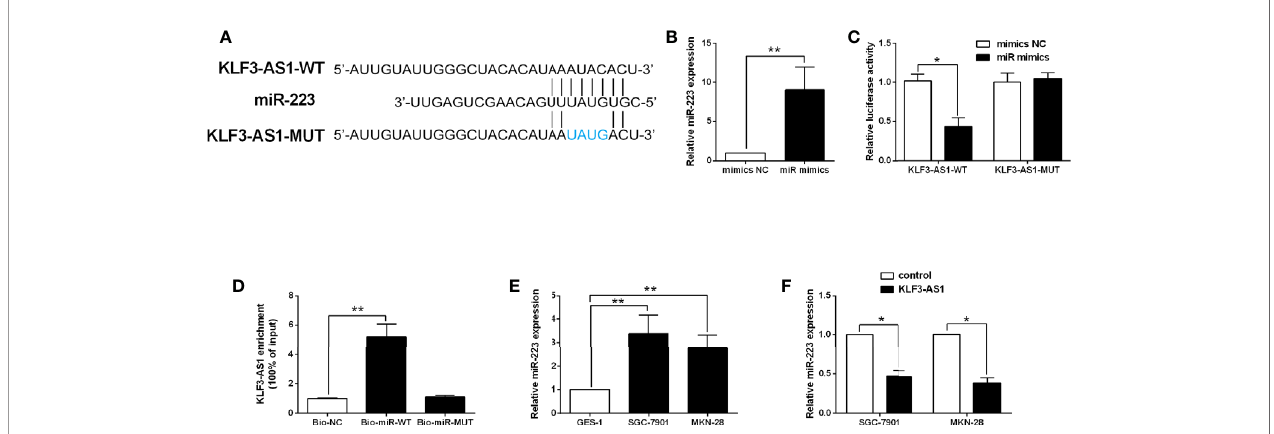
FIGURE 3 | KLF3-AS1 repressed miR-223 expression in gastric cancer cells. (A) The predicted binding seed sequences between KLF3-AS1 and miR-223 were illustrated. (B) SGC-7901 cells were transfected with miR-223 mimics or mimics NC, and miR-223 expression level in SGC-7901 cells was determined by qRT-PCR at 24 h after transfection (Student ’ s t-test). (C) The luciferase reporter activity of KLF3-AS1-WT and KLF3-AS1-MUT in SGC-7901 cells with miR-223 mimics or mimics NC transfection was determined by Dual-Luciferase Report Assay kit (Student ’ s t-test). (D) The RIP determined the physical interaction between miR-223 and KLF3-AS1 (one-way ANOVA followed by Bonferroni ’ s test). (E) The expression levels of miR-223 in the GES-1, SGC-7901 and MKN-28 cells were examined by qRT-PCR (one-way ANOVA followed by Bonferroni ’ s test). (F) The gastric cancer cells including SGC-7901 and MKN-28 were transfected with pcDNA3.1 (control group) or pcDNA3.1-KLF3-AS1 (KLF3-AS1), and at 24 h after transfection, the miR-223 expression level was determined by qRT-PCR (Student ’ s t-test). N = 3; *P < 0.05 and **P < 0.01.